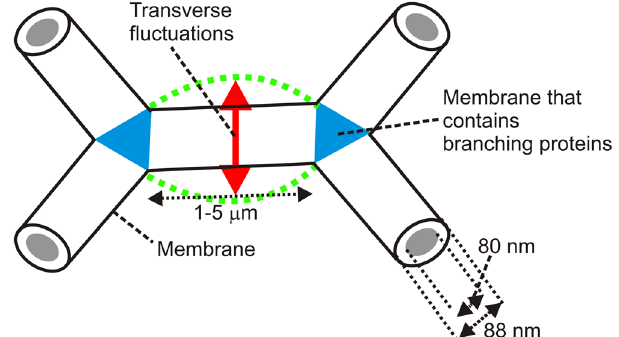
Figure 5. A schematic diagram that shows a fragment of the ER network’s tubular structure (not to scale). The distance between the branch points is in the range 1–5 μ m, the inner tubule diameter is 80 nm and the outer tubule diameter is 88 nm. Transverse fluctuations were measured based on the transverse mean square displacements τ ∆ ⊥ r ( ( ) ) 2 , shown in Fig. 4. The branched regions are labelled in blue in which specific S-type proteins are thought to occur 41